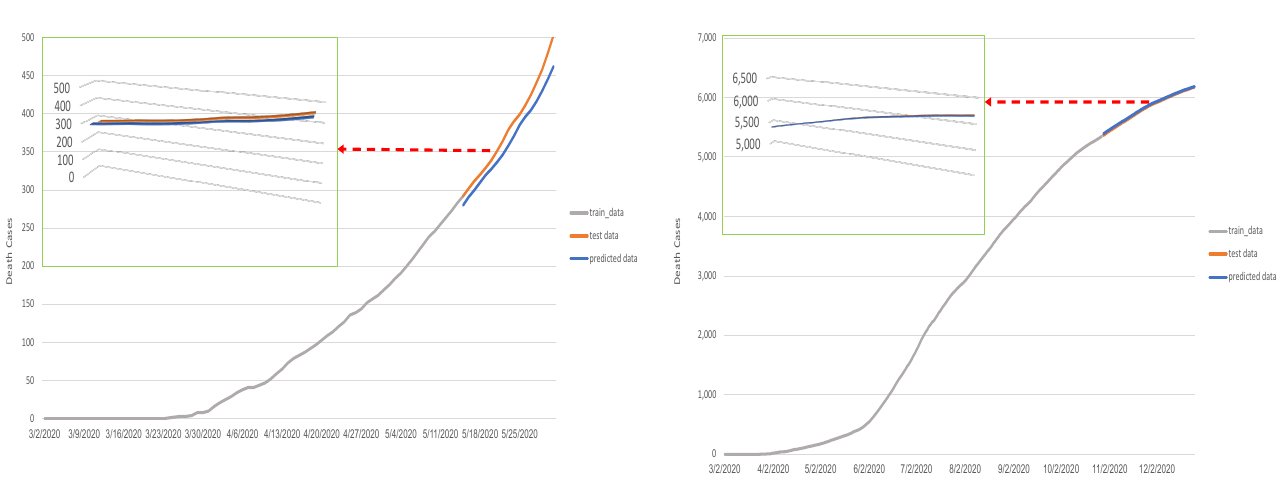
Figure 4. The forecasting results of COVID-19 spread for our proposed method in Saudi Arabia. ( a ) Confirmed cases forecasting results in the start of the COVID-19 first wave in Saudi Arabia. ( b ) Confirmed cases forecasting results in the ending of the COVID-19 first wave in Saudi Arabia. ( c ) Recovered cases forecasting results in the start of the COVID-19 first wave in Saudi Arabia. ( d ) Recovered cases forecasting results in the ending of the COVID-19 first wave in Saudi Arabia. ( e ) Death cases forecasting results in the start of the COVID-19 first wave in Saudi Arabia. ( f ) Death cases forecasting results in the ending of the COVID-19 first wave in Saudi Arabia.